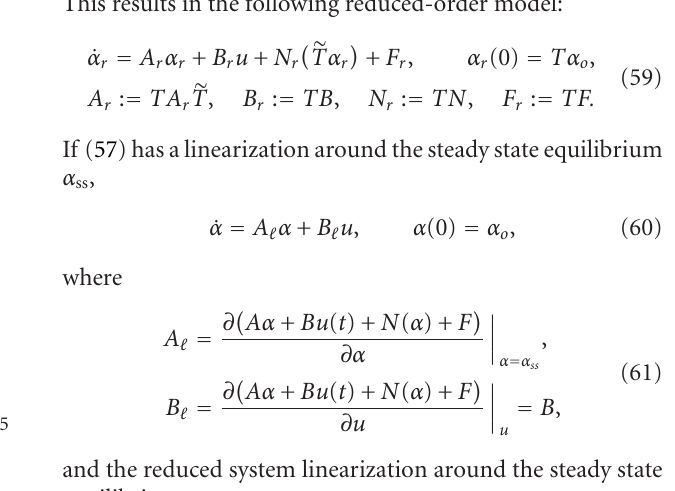
Figure 5: Excitation inputs for ERA